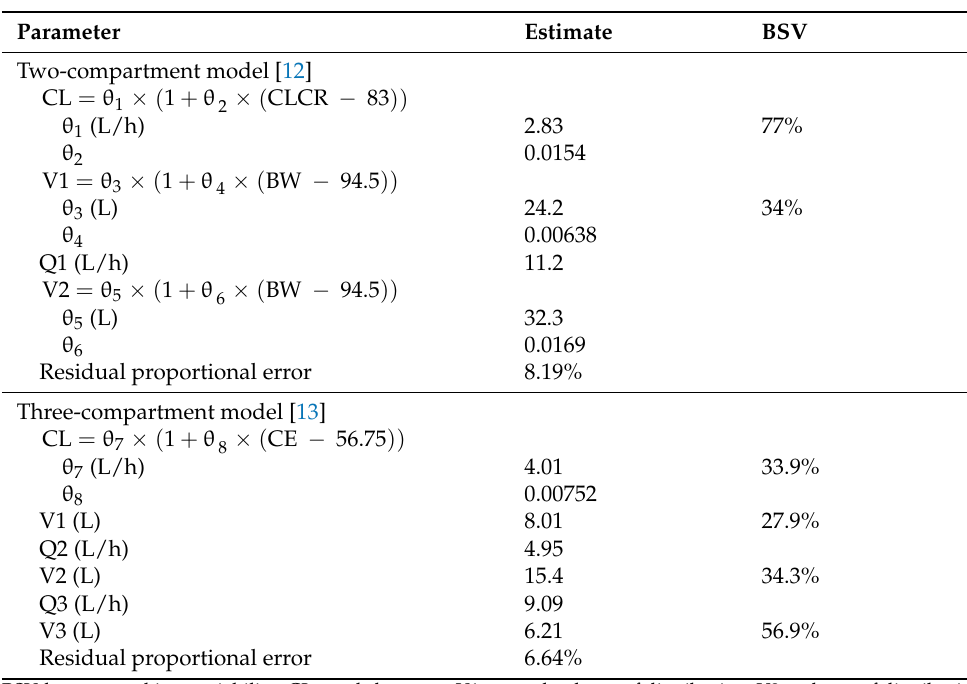
Table 1. Population PK parameter values used for simulation.